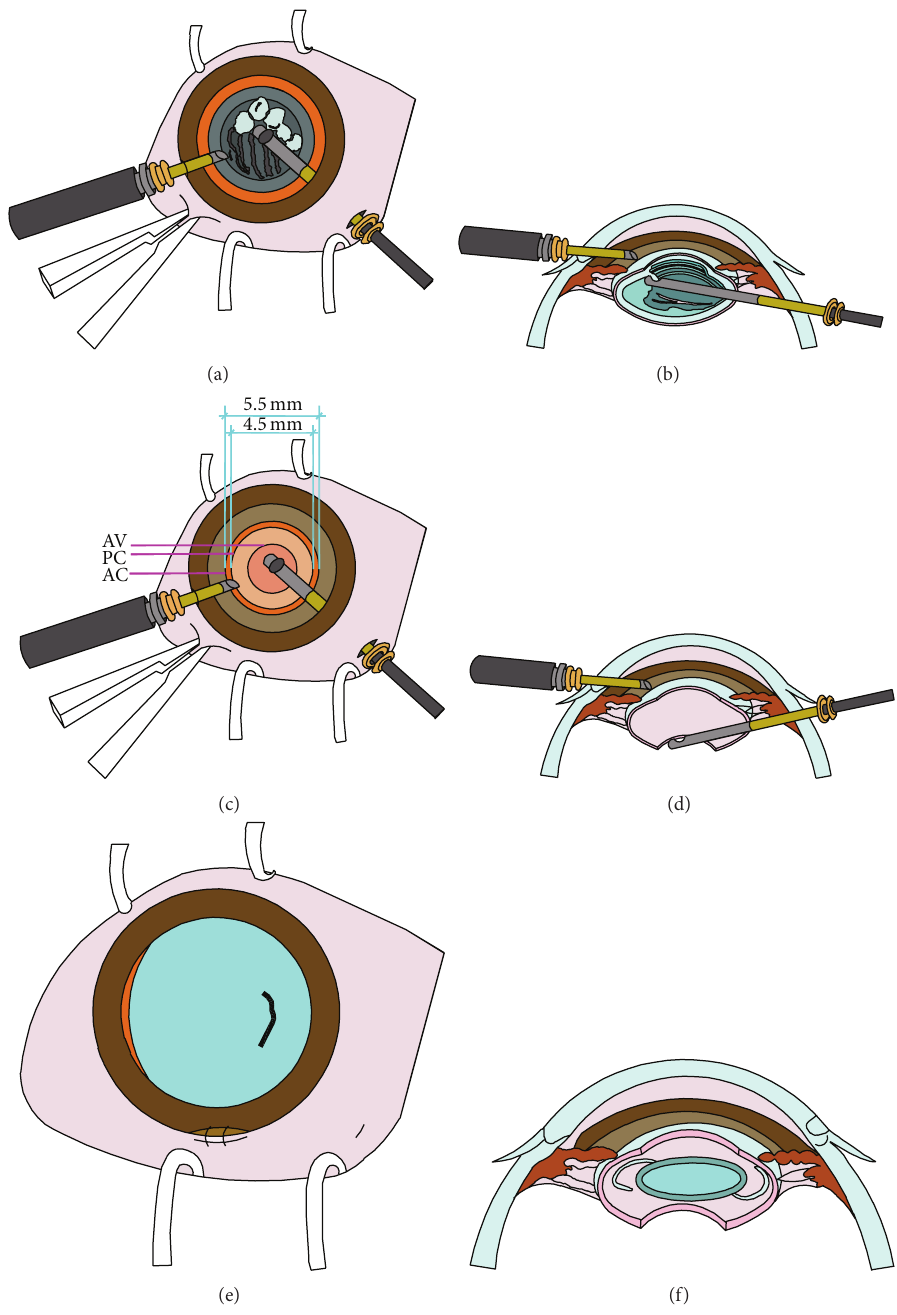
Figure 3: (a) Lensectomy was performed after a central anterior capsulotomy using a 23-gauge vitrectomy cutter via a pars plana incision, which was 2.5 mm posterior to the limbus. (b) Cross-sectional diagram shows the lensectomy procedure. (c) Anterior vitrectomy after a posterior capsulotomy of 4.5 mm diameter. (d) Cross-sectional diagram shows the anterior vitrectomy procedure. (e) Status at the end of surgery. Another 2.6 mm limbal incision was made for IOL implantation and was closed with 2 sutures at the end of the surgery. (f) Cross- sectional diagram shows the status at the end of